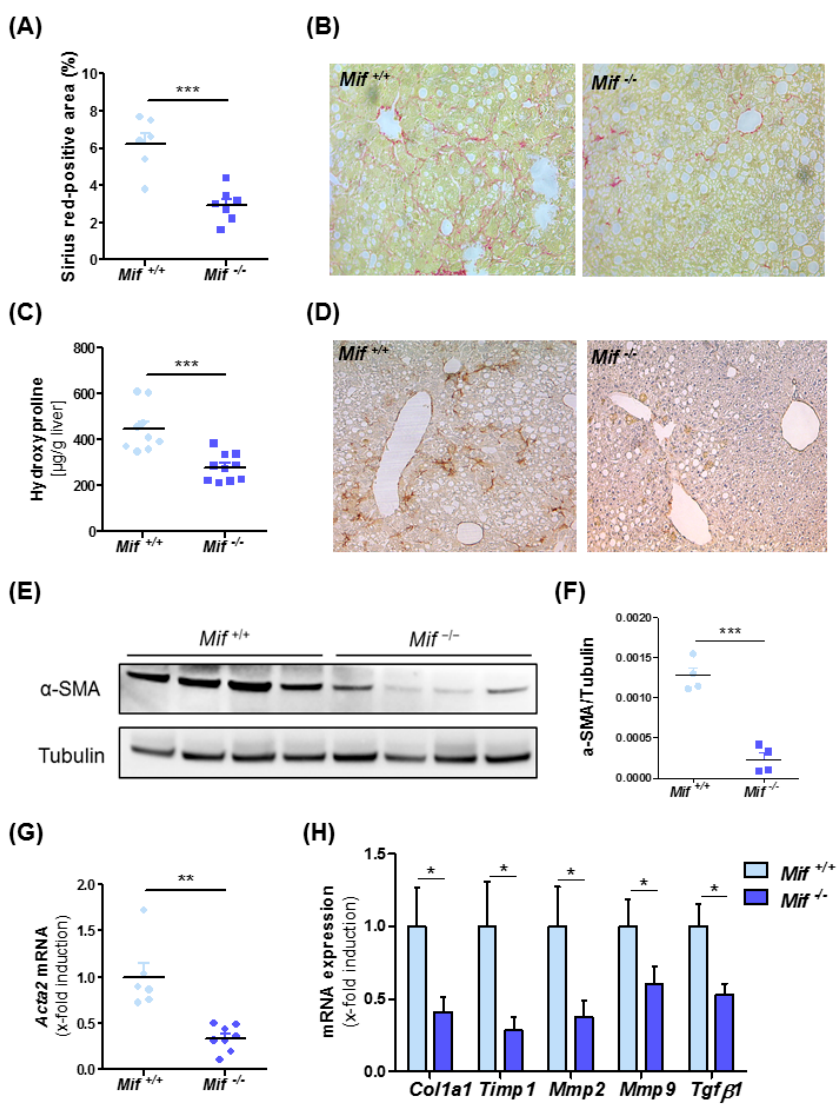
Figure 2. Decreased liver fibrosis progression in Mif -deficient mice in an experimental NASH model. ( A ) Quantification and ( B ) representative images of sirius red staining of WT and Mif − / − mice after 8 weeks of MCD feeding. ( C ) Decreased fibrosis in Mif − / − mice compared to WT ( n = 10 per group) was confirmed by significantly decreased concentrations of hydroxyproline within the liver. ( D ) Immunhistochemical stainings for α -SMA in liver samples of WT and Mif − / − mice after 8 weeks of MCD feeding. ( E ) Immunoblot analysis on whole liver tissue of WT and Mif − / − mice after 8 weeks of MCD feeding using antibodies against α -SMA, tubulin served as loading control. ( F ) Relative α -SMA protein level. ( G ) Relative Acta2 mRNA expression in total liver tissue of WT and Mif − / − mice after 8 weeks of MCD feeding ( n = 10 per group) quantitated using qRT-PCR (fold induction normalized to control animals). ( H ) Expression patterns of fibrosis-related genes, e.g., Col1a1 , Timp1 , Mmp2 , Mmp9 , and Tgf- β 1 , were measured by qRT-PCR between Mif + / + mice and Mif − / − mice ( n = 10 per group). Asterisks indicate statistical significance: * p < 0.05; ** p < 0.01; *** p <